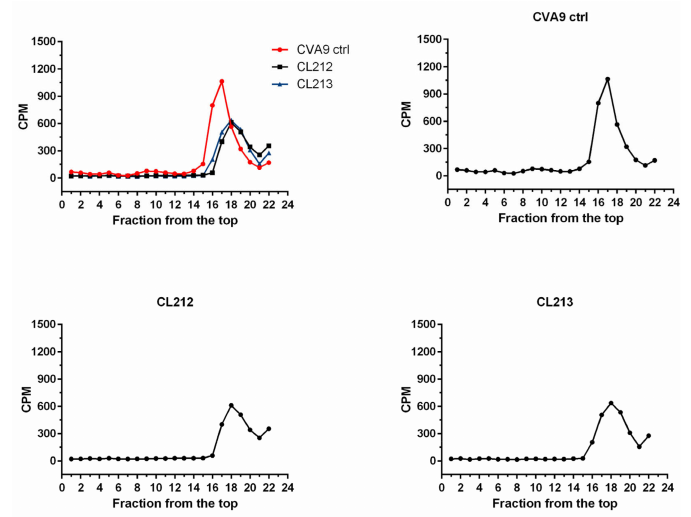
Figure 6. The effect of CL212 and CL213 on the virus capsid using metabolically labeled CVA9. CVA9 was treated with CL212 or CL213 for 1 h at +37 ◦ C and then added on top of a 5–20% sucrose gradient. The fractions were collected from the top and radioactivity was measured as counts per minute (CPM) for each separate fraction.